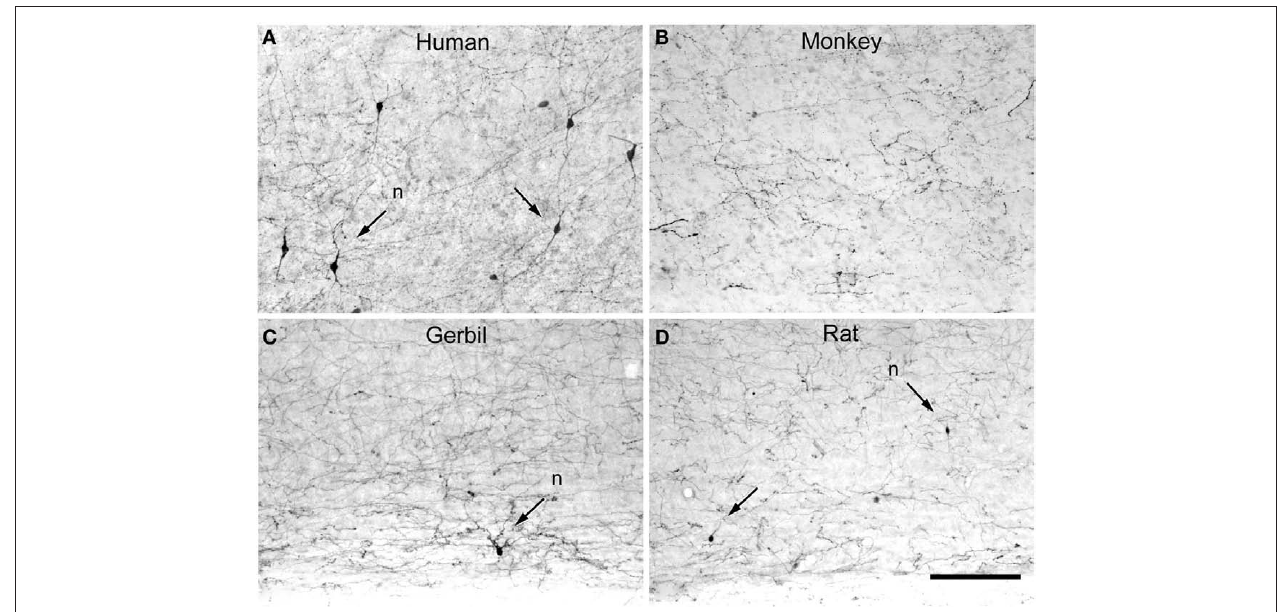
abundant in the deep layers of the human neocortex when compared to other species. However, they are occasionally found in the somatosensory cortex of the rat and gerbil whereas in the macaque monkey no TH neurons were observed in the in the lateral temporal cortex. Nevertheless, in other cortical areas of the monkey these cells are also present in deep layers. Scale bar = 160